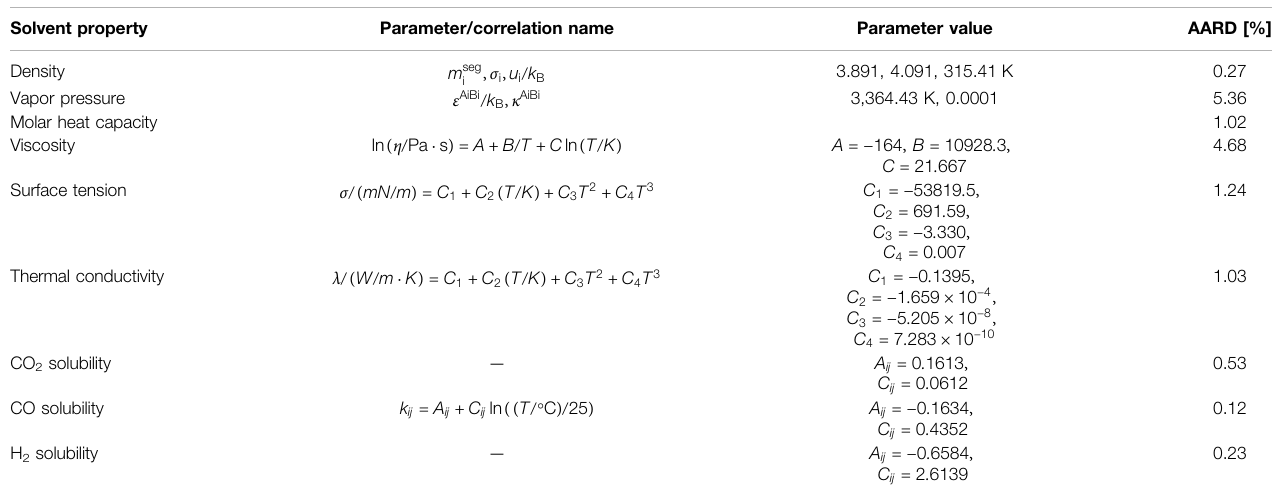
TABLE 3 | Model parameters for deca-men properties and the